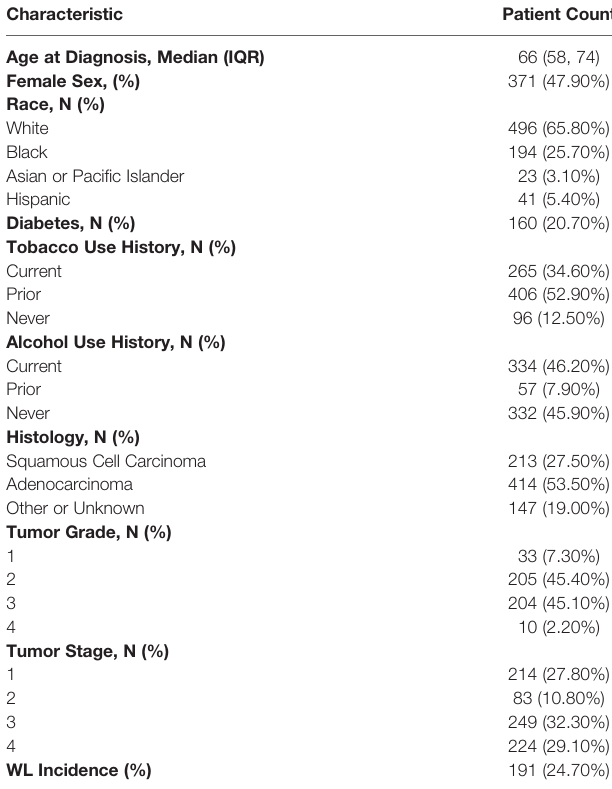
TABLE 1 | Patient Characteristics and Incidence of Signi fi cant Pretreatment Cancer-Associated Weight Loss (WL).